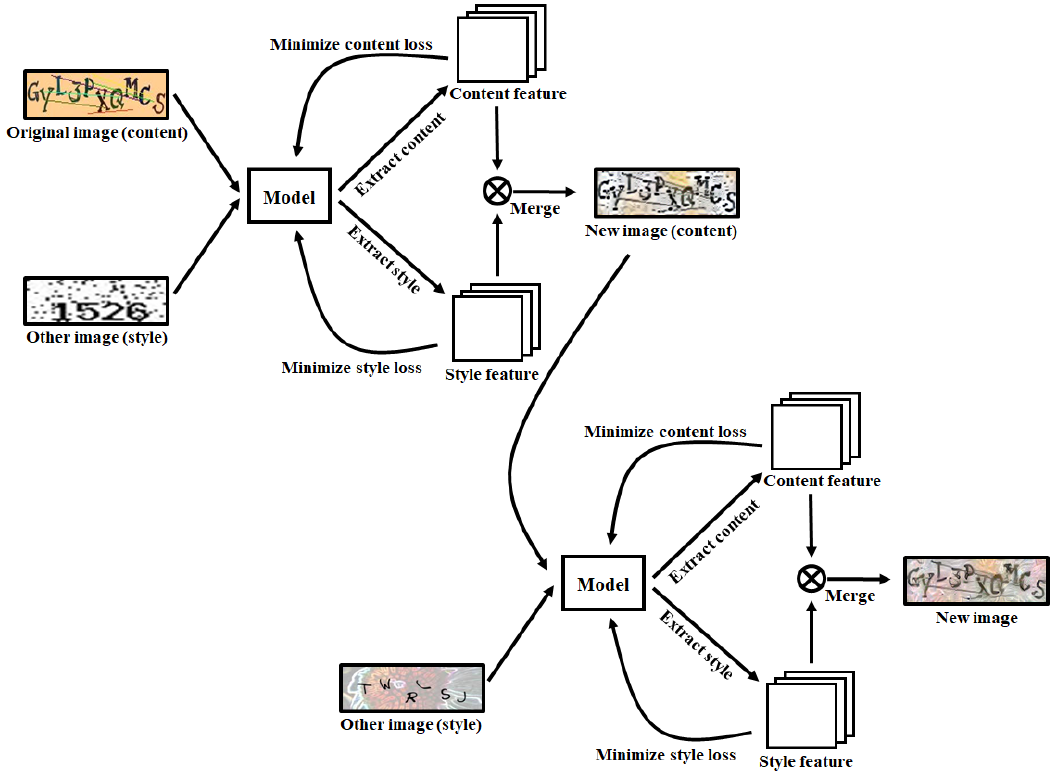
Figure 2. Architecture of the proposed